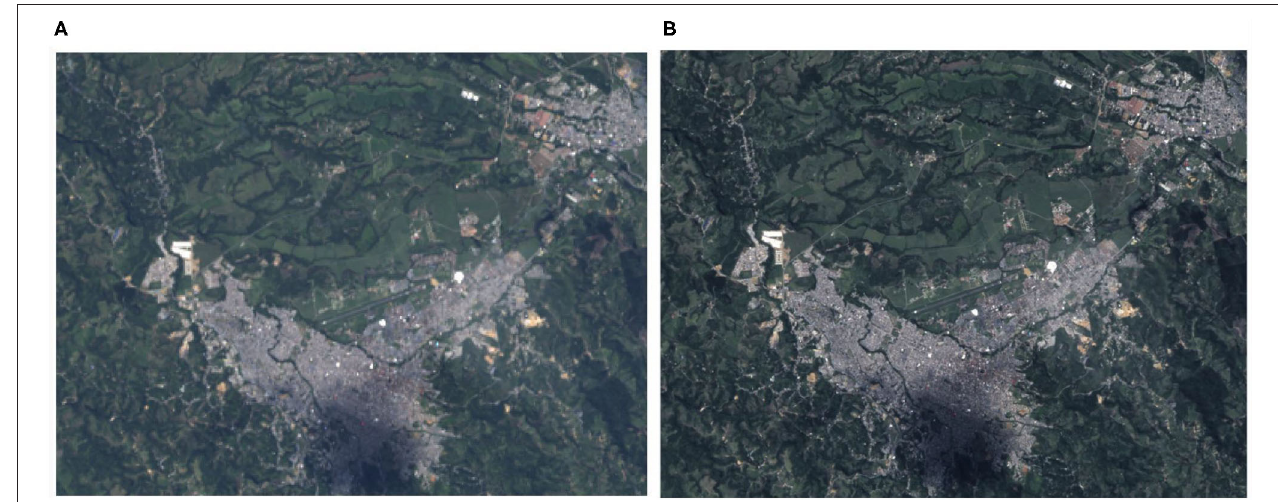
FIGURE 3 | Increased resolution. (A) Landsat satellite image of the municipality of Popayán with the original RGB resolution of 30 m/px. (B) Landsat satellite image of the municipality of Popayán with the increased RGB resolution of 15